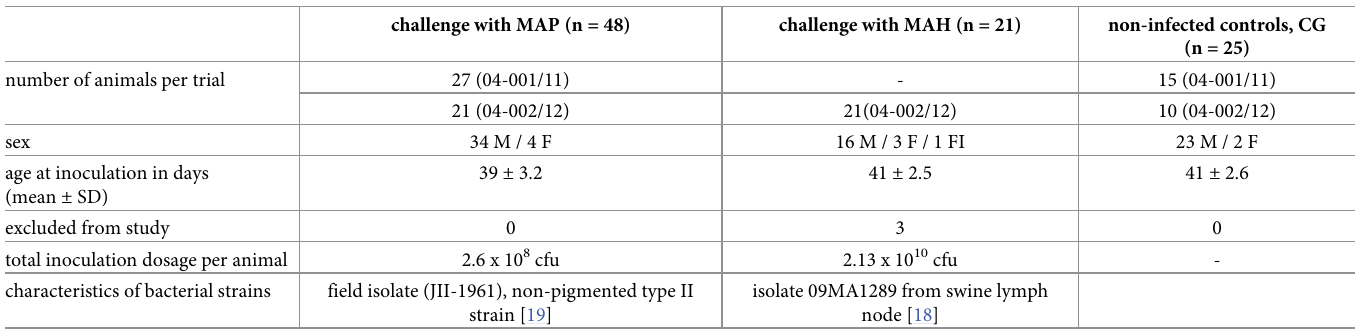
Table 1. Challenge groups and non-infected control groups of both trials.